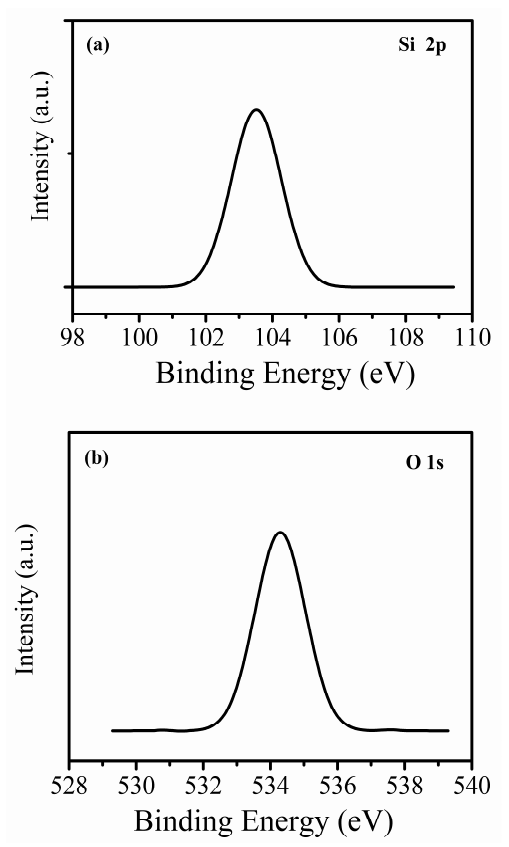
Figure 3. The XPS spectra of SiO 2 thin films deposited by PECVD. ( a ) Si 2p spectra; ( b ) O 1s spectra.